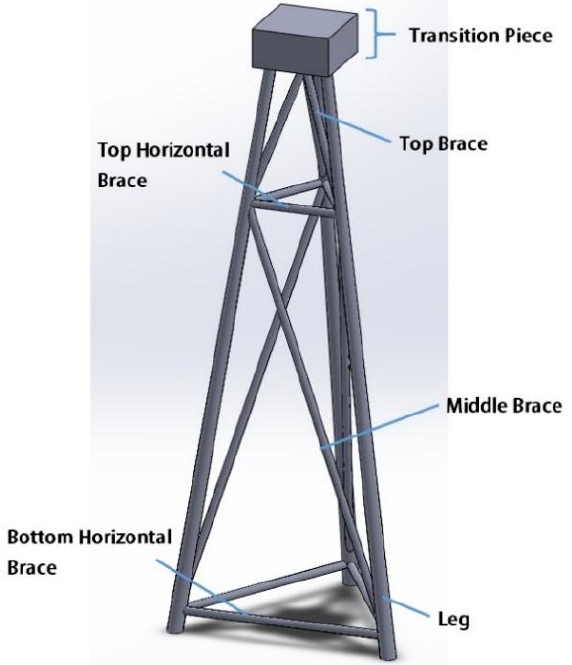
Figure A8. Terminology of the structural members of an MJ-structure.